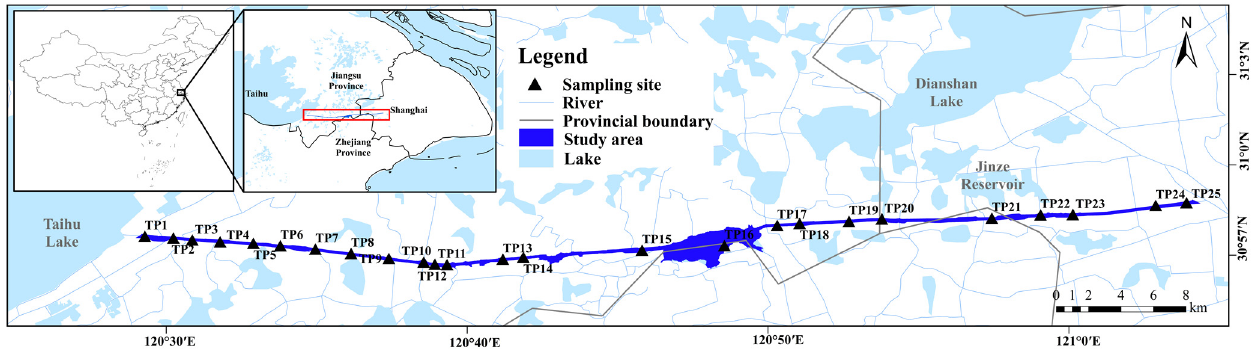
Figure 1. The Sampling sites map of the Taipu River sediments (map source: National Catalogue Service For Geographic Information and Map World: www.tianditu.gov.cn (accessed on on 16 August 2021)).